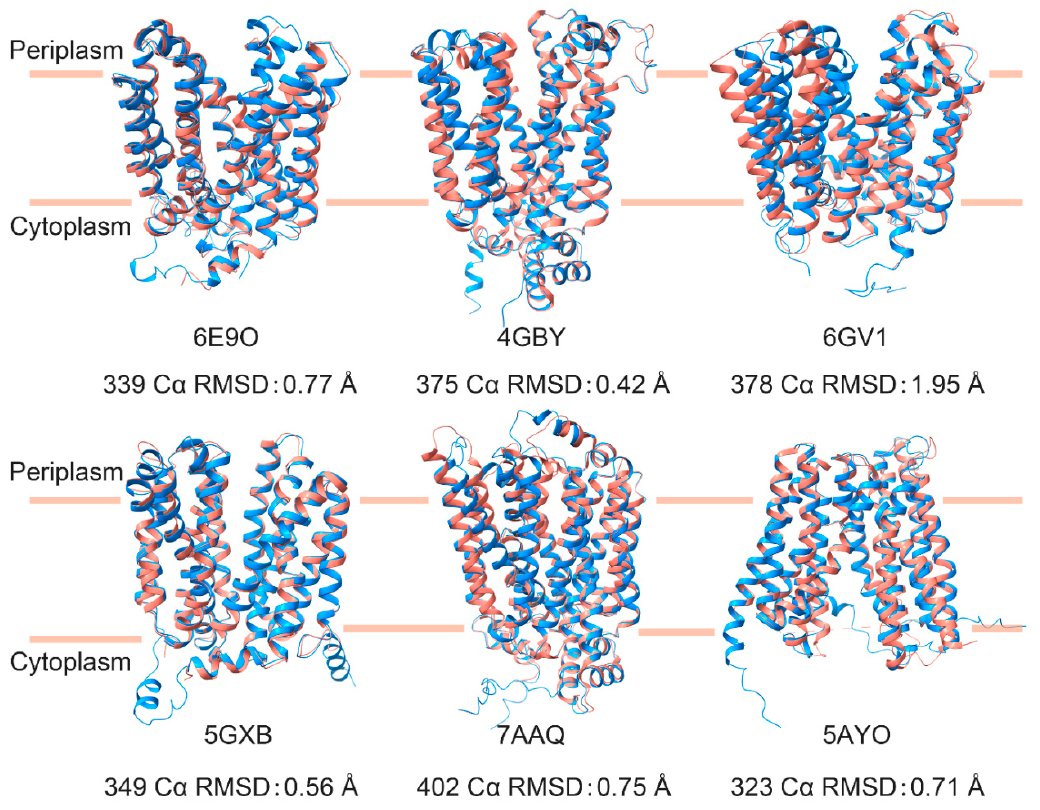
Figure 3. Structural alignment between the predicted structure (mutant, dodger blue) and the experimental structure (salmon). The PDB numbers corresponding to the UniProt ID are 6E9O and P0AA76, 4GBY and P0AGF4, 6GV1 and P0AEY8, 5GXB and P02920, 7AAQ and Q9LT15, and 5AYO and